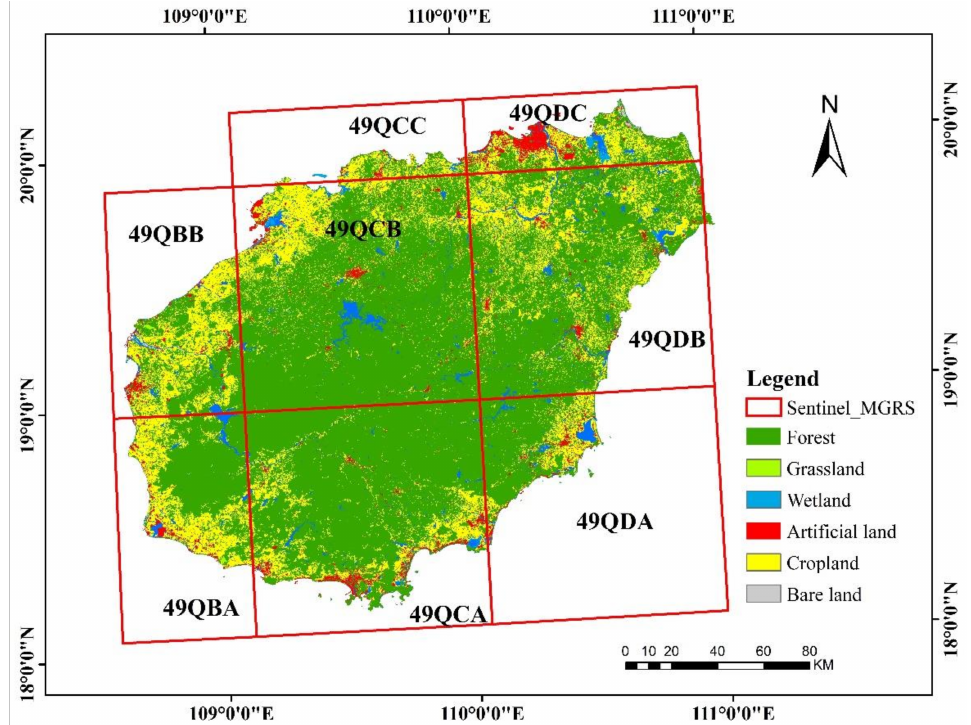
Figure 3. Hainan land cover from “ChinaCover2020” and Sentinel-2 tiles for the study